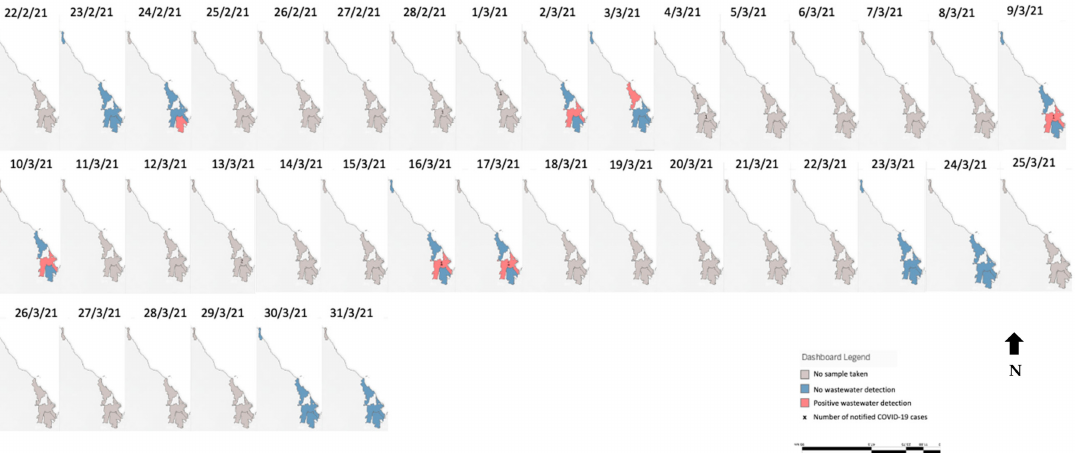
Figure A2. Cairns cluster. Maps of positive wastewater detections of SARS-CoV-2 and